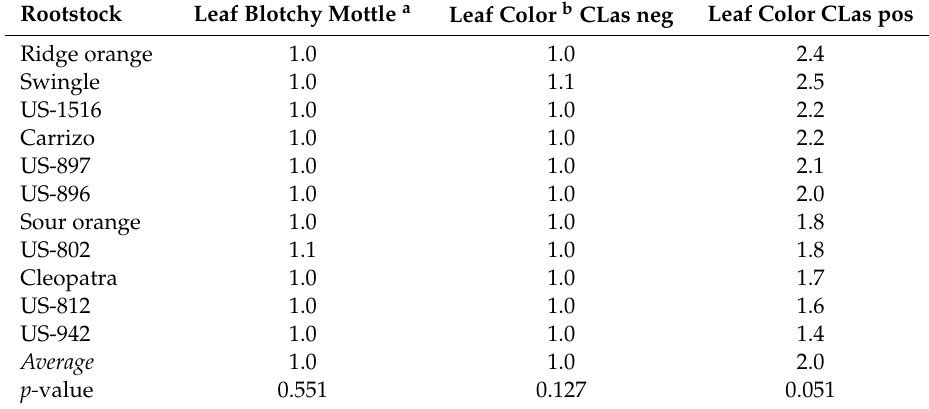
Table 6. Leaf symptoms of HLB (blotchy mottle) and leaf yellowing at 50 wai.